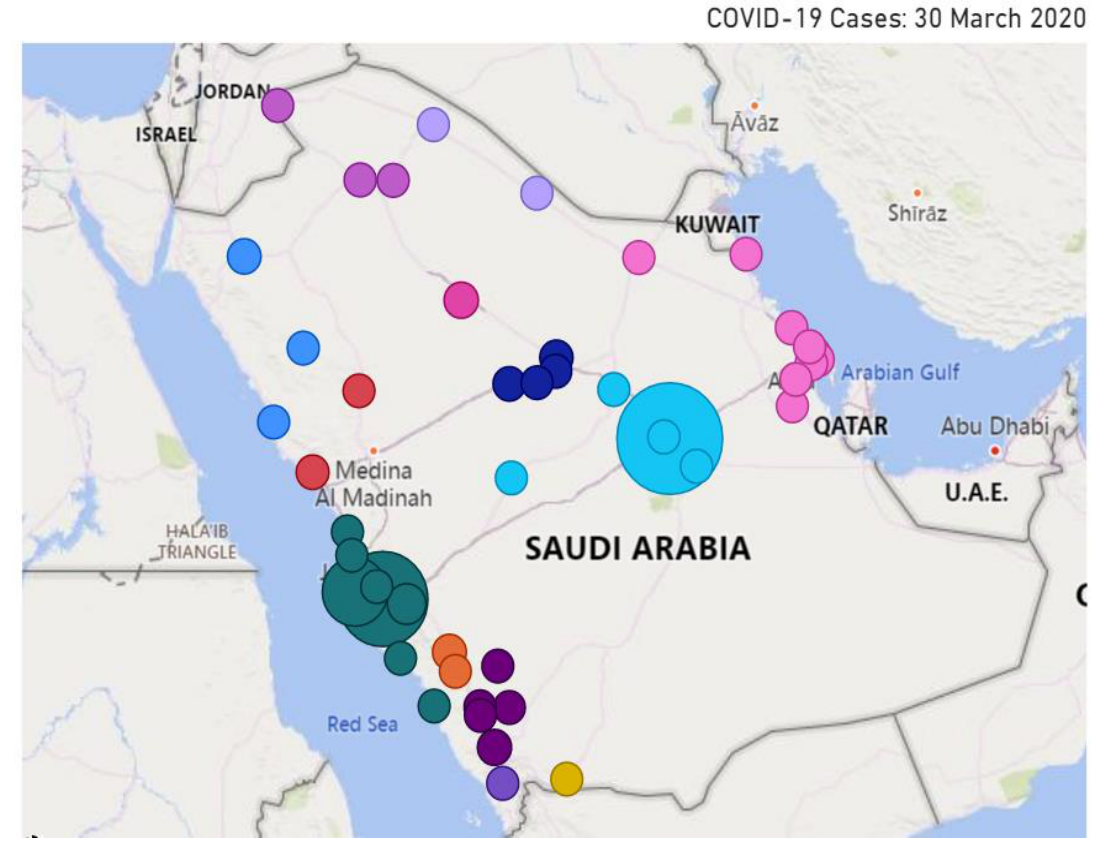
Figure 15. Spatio-temporal behavior of public concern (COVID-19 cases: 30 March 2020).